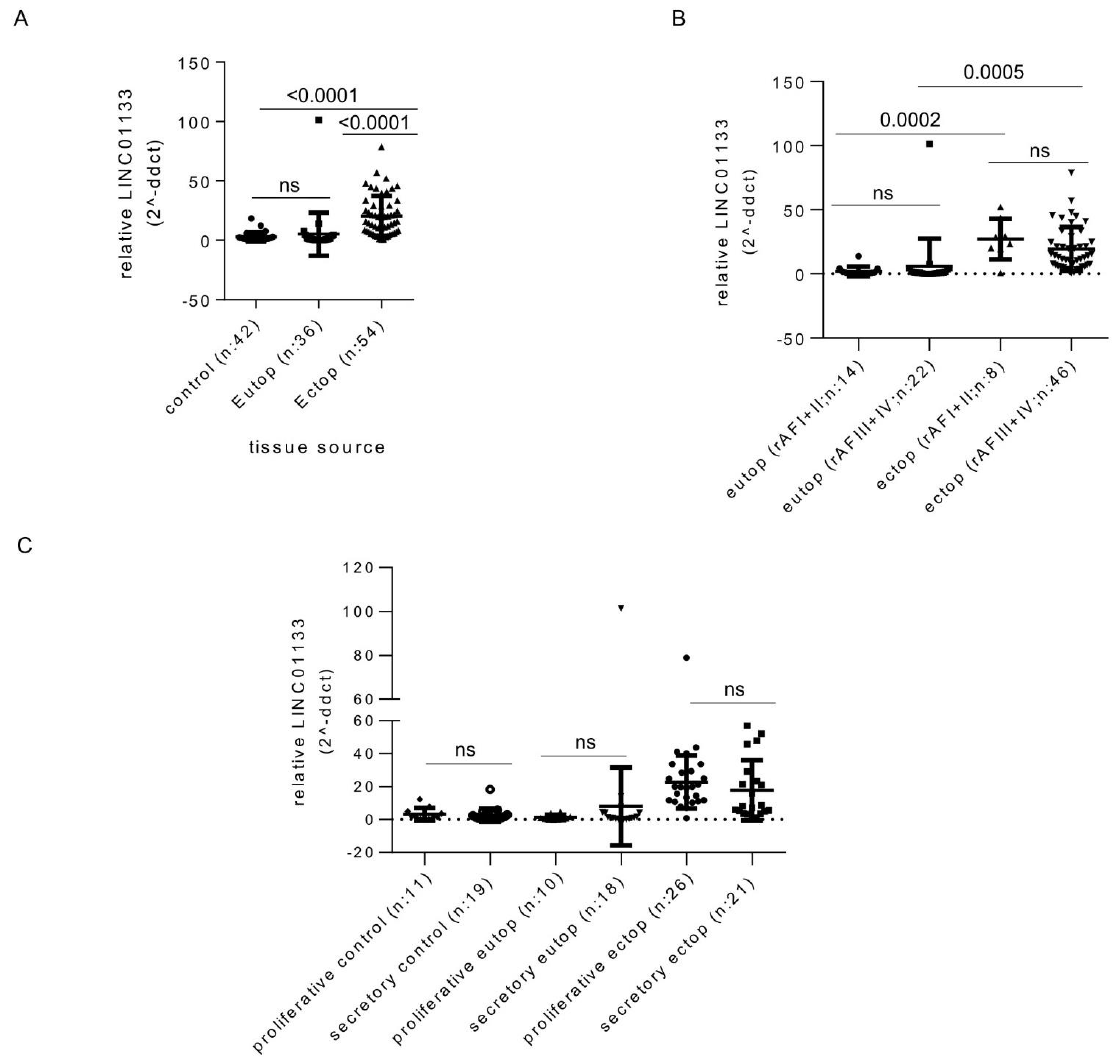
Figure 1. LINC01133 expression is upregulated in endometriosis lesions. ( A ) Relative expression of LINC01133 is significantly increased in ectopic endometriotic lesions compared to the eutopic endometrium of women with and without endometriosis. Expression in the eutopic endometrium does not differ between women with and without the disease. ( B ) In endometriosis patients, LINC01133 expression does not significantly differ between mild (rAF I + II) and more severe (rAF III + IV) disease stages, in either the eutopic endometrium or ectopic lesions. ( C ) LINC01133 expression does not significantly differ between the proliferative and secretory stages of the menstrual cycle in control eutopic endometrium, eutopic endometrium from patients, or ectopic lesions. Data in ( A – C ) are presented as dot plots including the mean relative expression levels and standard deviation in each group As the sample sizes were not equal, data were analyzed by fitting a mixed model, rather than repeated measures ANOVA (which requires equal sample size). Adjusted p -values values (adjp) < 0.05 were considered significant with non-significant differences indicated by ns. Control: endometrial tissue of women without endometriosis, Eutop: endometrial tissue of women with endometriosis, Ectop: endometriosis lesions.